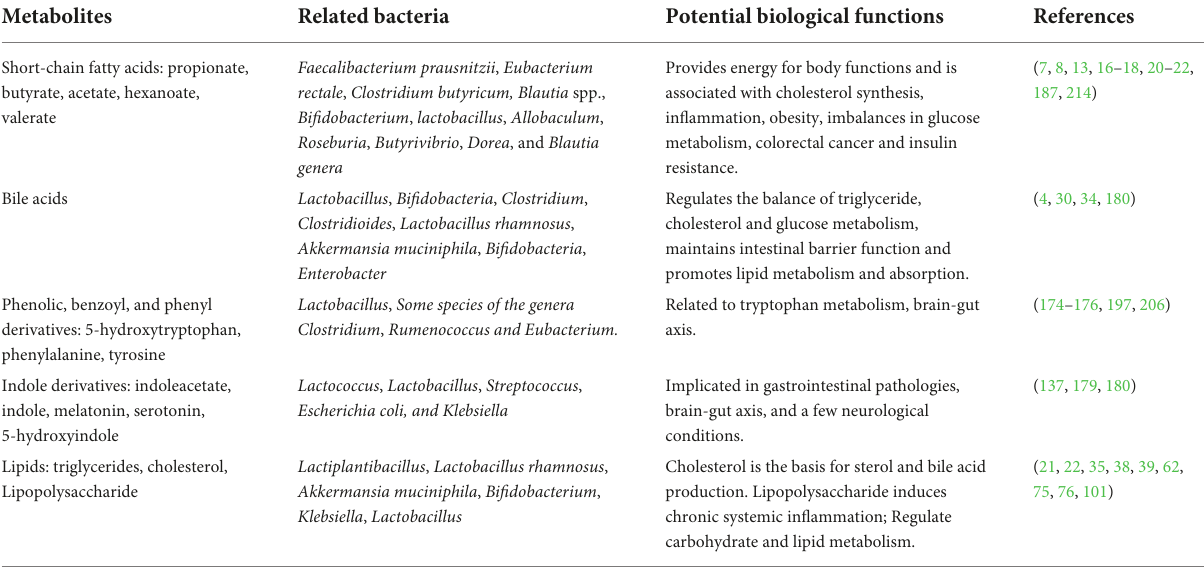
TABLE 1 Gut bacteria and the metabolites they